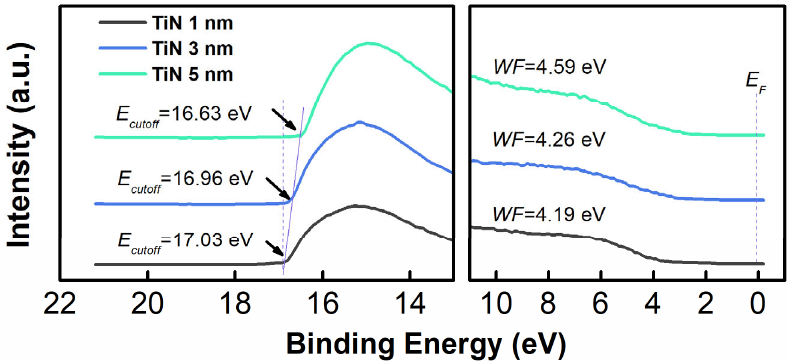
Figure 5. UPS spectra of the Cr/Al/Cr/TiN anodes with different thicknesses of TiN.